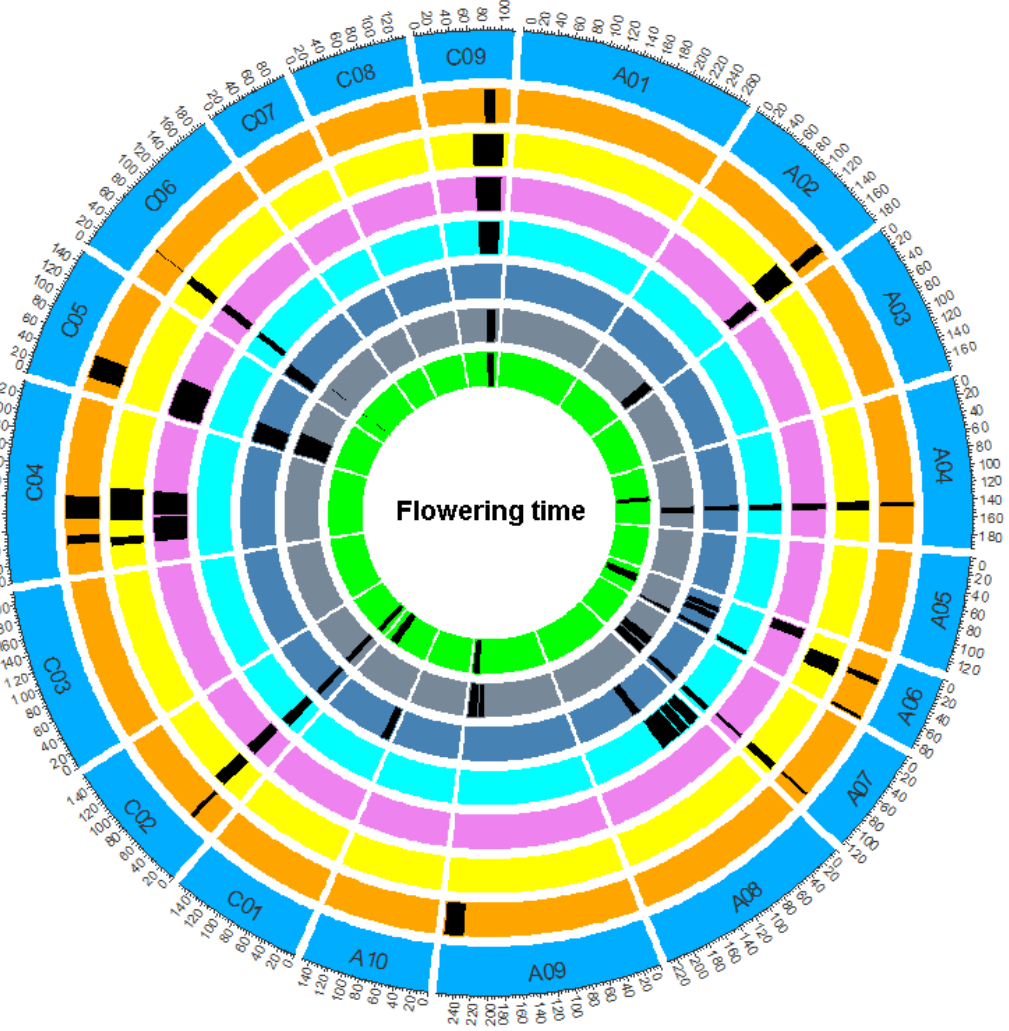
Figure 4. Schematic diagram of QTL mapping for flowering time in the 158A-SGDH population. The circles from outside to inside show the consensus QTL and the identified QTL of the flowering time. The outermost circle is the chain group, the second orange circle represents the consensus QIL position, and the third circle inward represents different repetitions in different environments, followed by FY20.1, FY20.2, FY19.1, FY19.2, FY19.3, and FY18.1. The black area in the circle indicates the positions of the consensus QTL and the identified QTL.